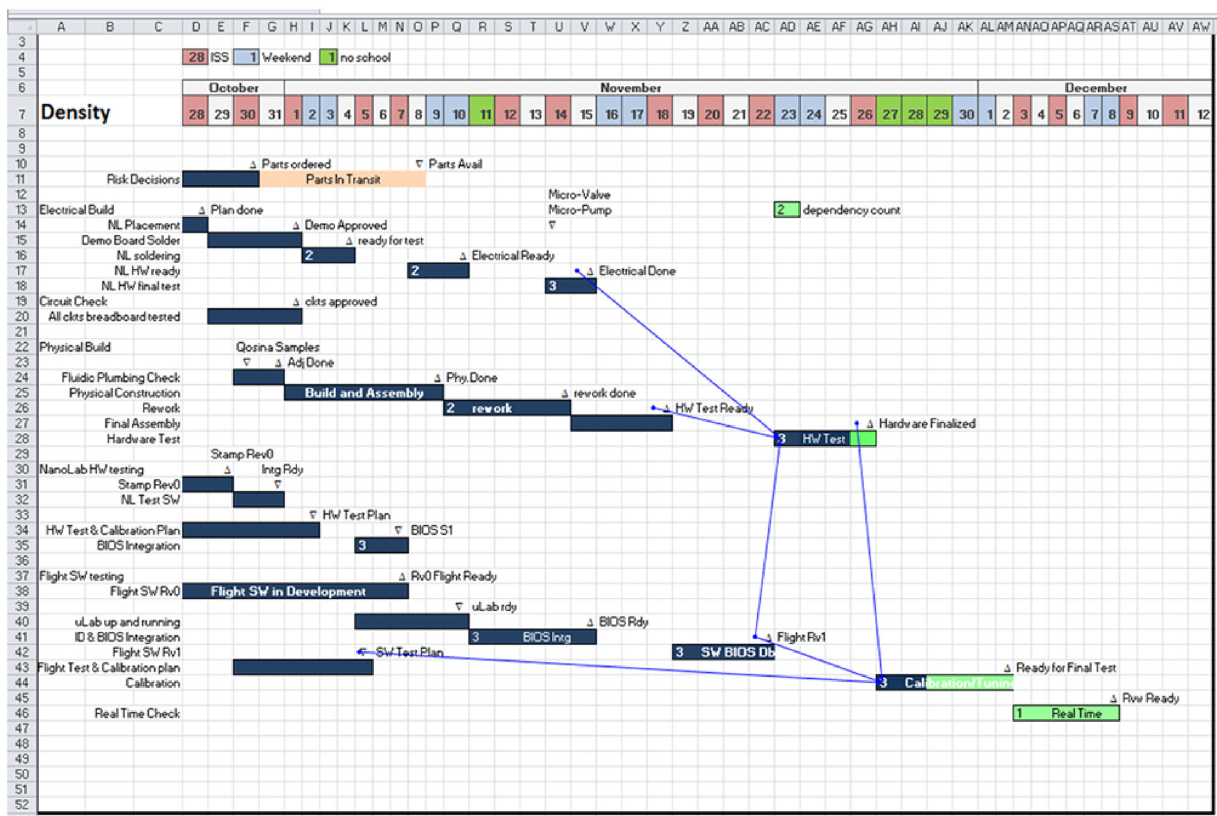
Fig. 7 Example Gantt project schedule used by the density team leader showing dependencies between